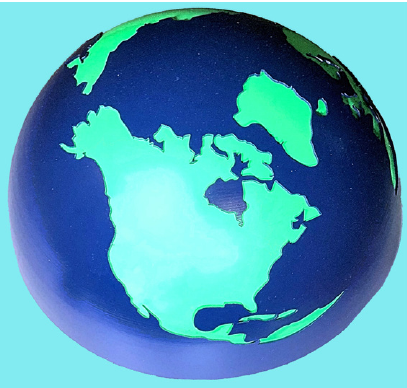
Figure 10: AWJ-machined map of North America on steel hemi- sphere.